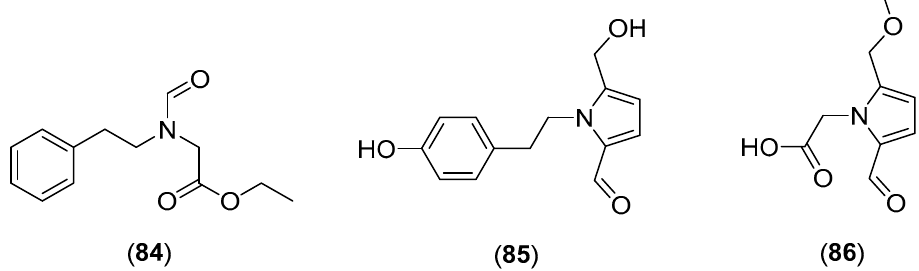
Figure 16. Chemical structures of selected compounds isolated from Rugiboletus extremiorientalis. 5.18. Russula virescens (Schae ff .)